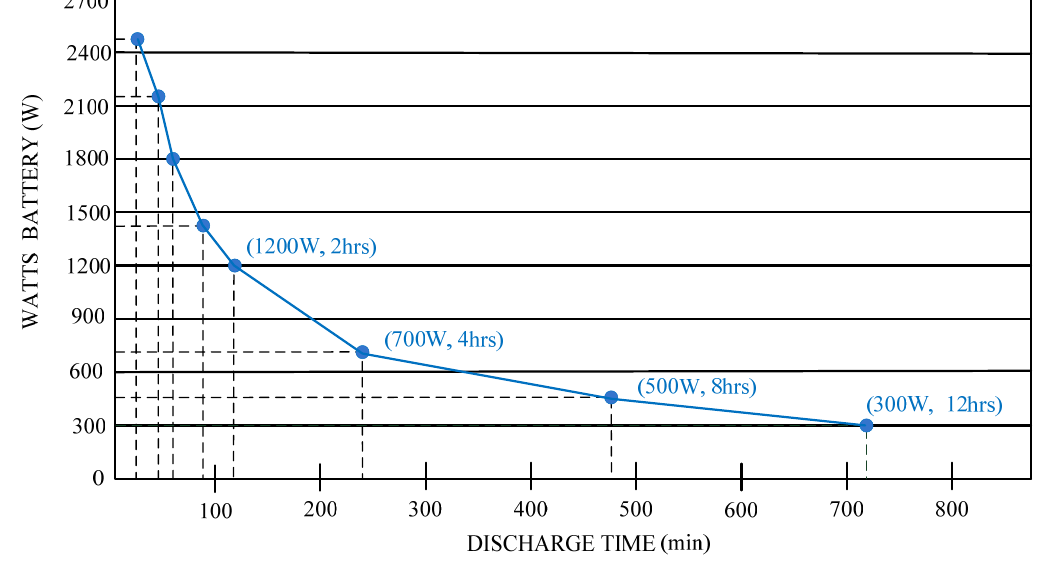
Figure 20. Plot of discharge time versus discharge current (CA) of batteries supplied by the battery